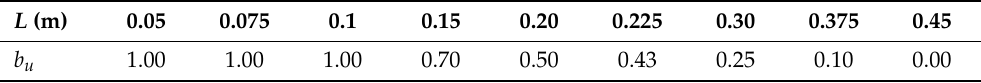
Table 4. Coefficient b u versus pipe spacing L for type B systems